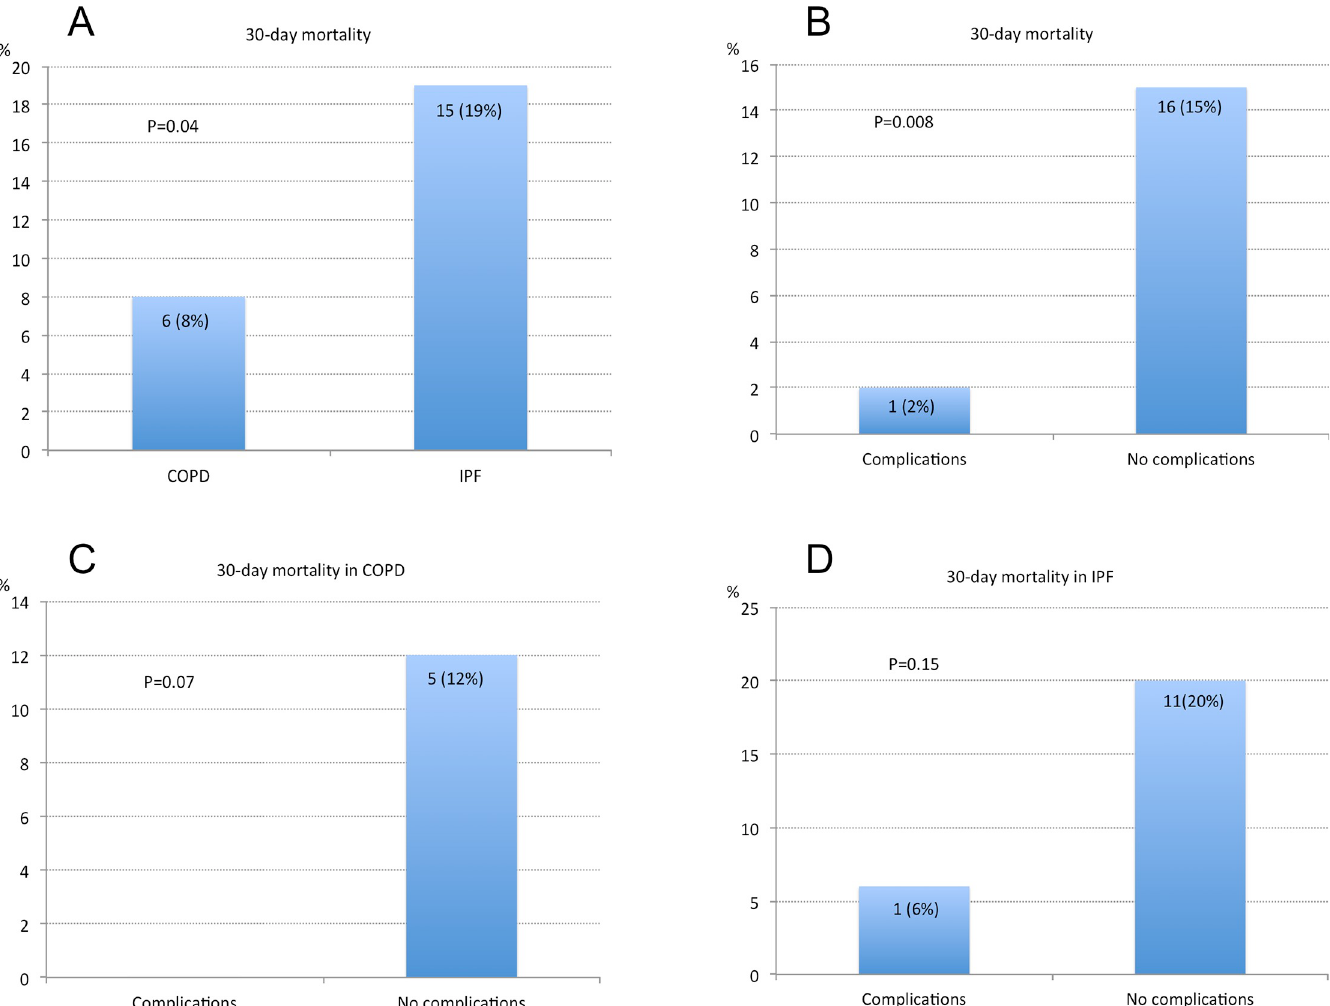
Fig 1. 30-day mortality. A) 30-day mortality of COPD vs. IPF patients after single lung transplantation. B) 30-day mortality in patients with or without native lung complications (overall study group). C) 30-day mortality in COPD patients with or without native lung complications. D) 30-day mortality in IPF patients with or without native lung